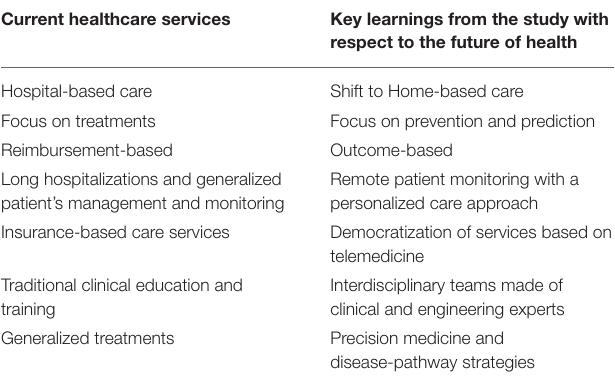
TABLE 1 | Healthcare visions based on the survey results. Current healthcare